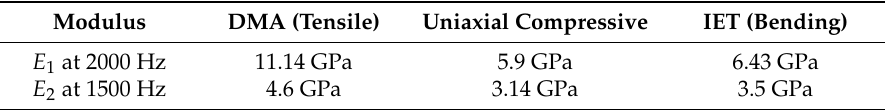
Table 1. The values of E 1 at 2000 Hz and E 2 at 1500